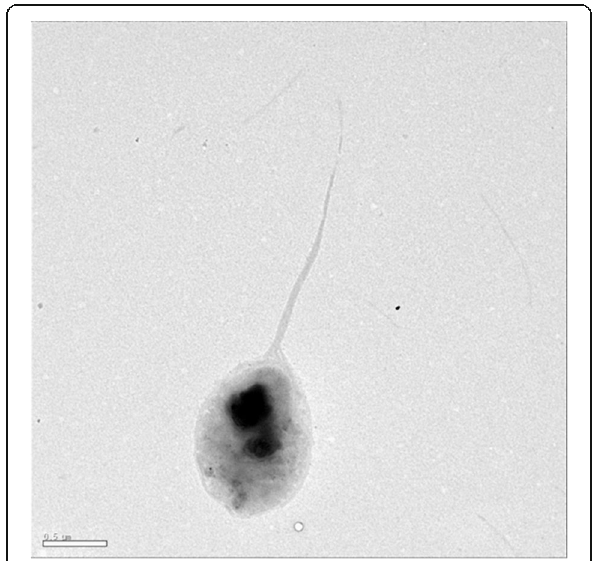
Fig. 2 Transmission electron micrograph (TEM) of K. konosiri X49 T